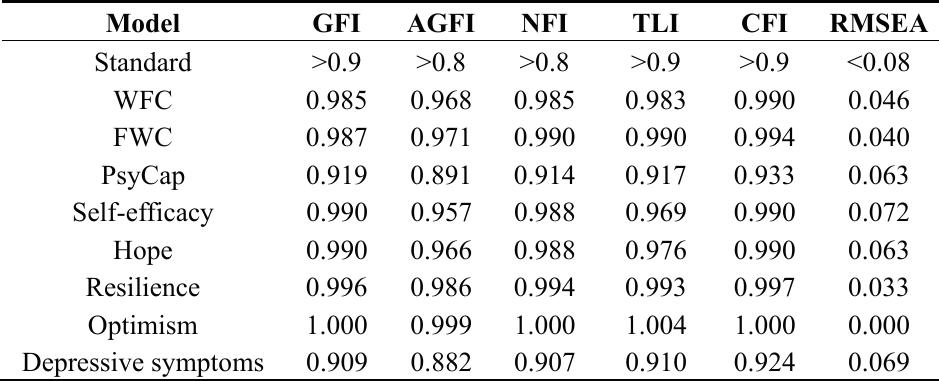
Table 1 . The validities for the